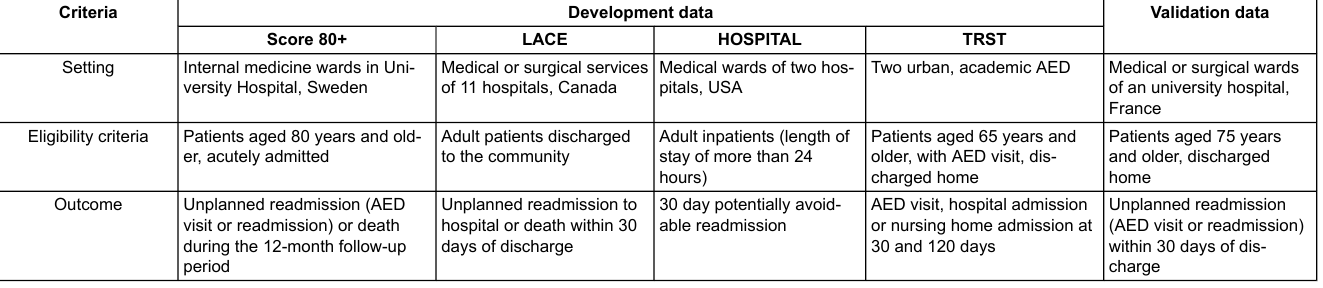
Table 2: Differences between development data and validation